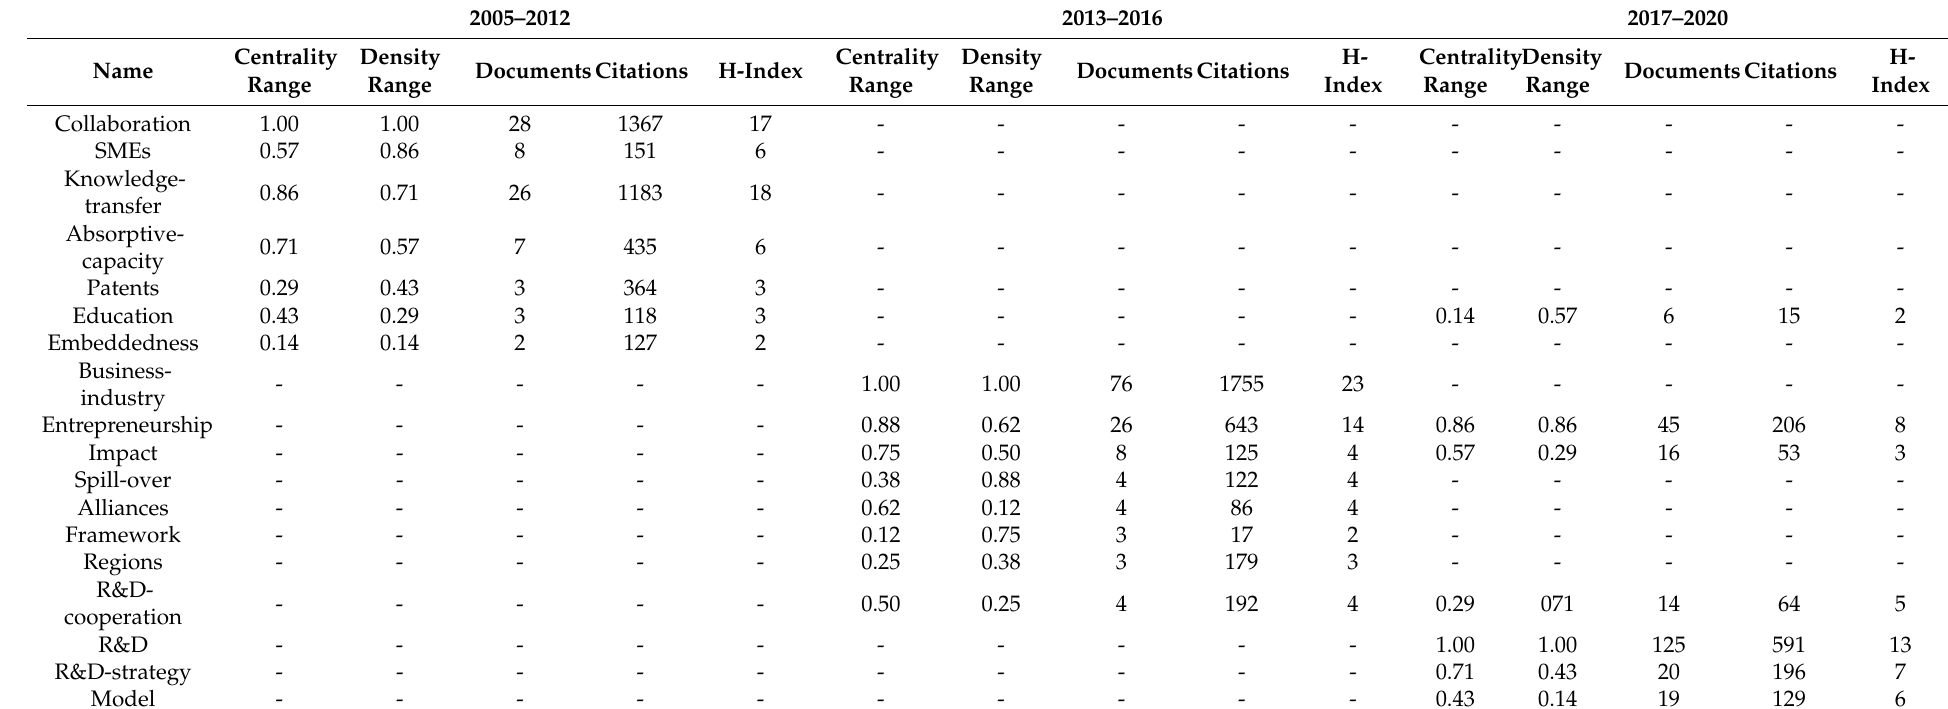
Table 4. Quantitative and qualitative factors of the themes and their